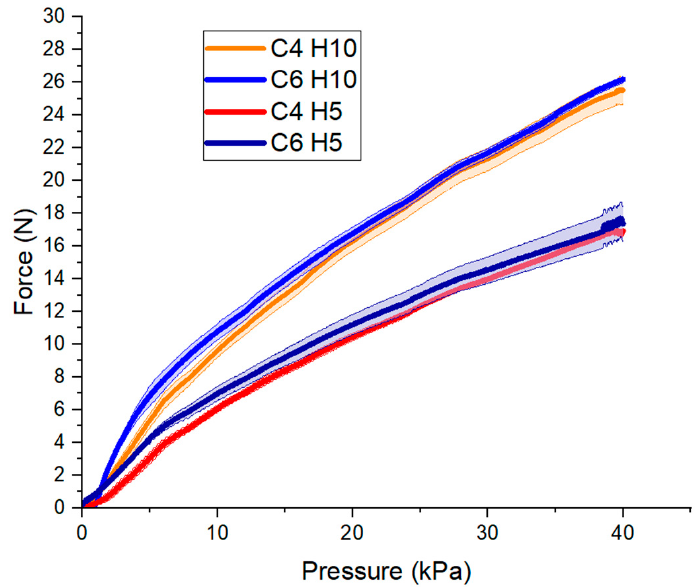
Figure 7. Force versus actuation vacuum pressure magnitudes for actuators held fixed at uncontracted length, where C stands for number of cells and H stands for skeleton height (in millimeters).